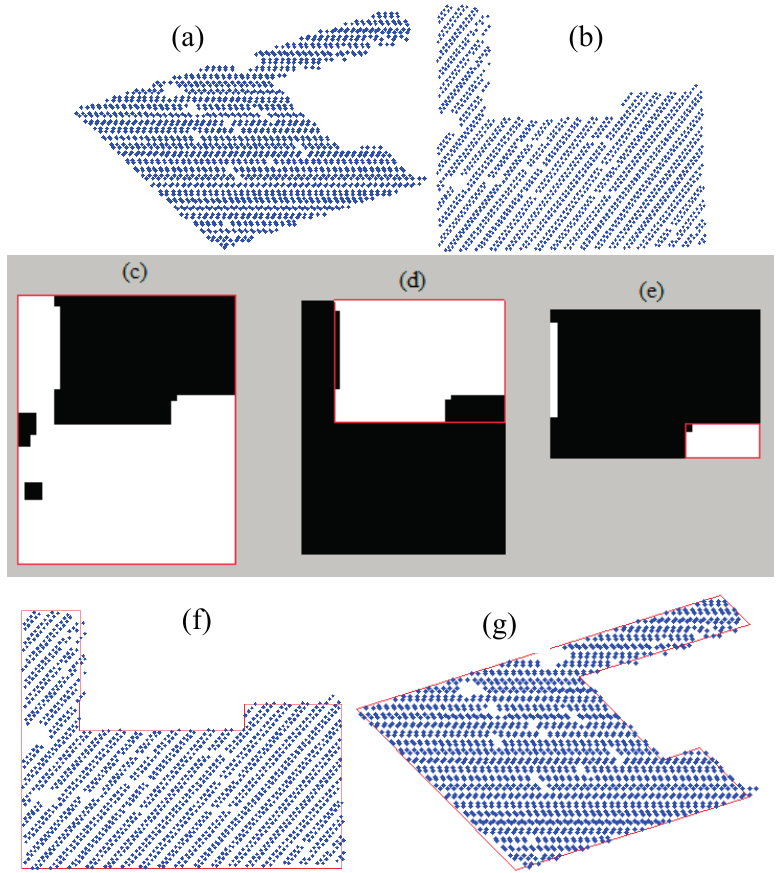
Figure 7. Outline extraction from binary images: ( a ) roof patch point cloud; ( b ) roof patch rotation to horizontal or vertical direction; ( c ) extract the MBB of the patch; ( d ) obtain